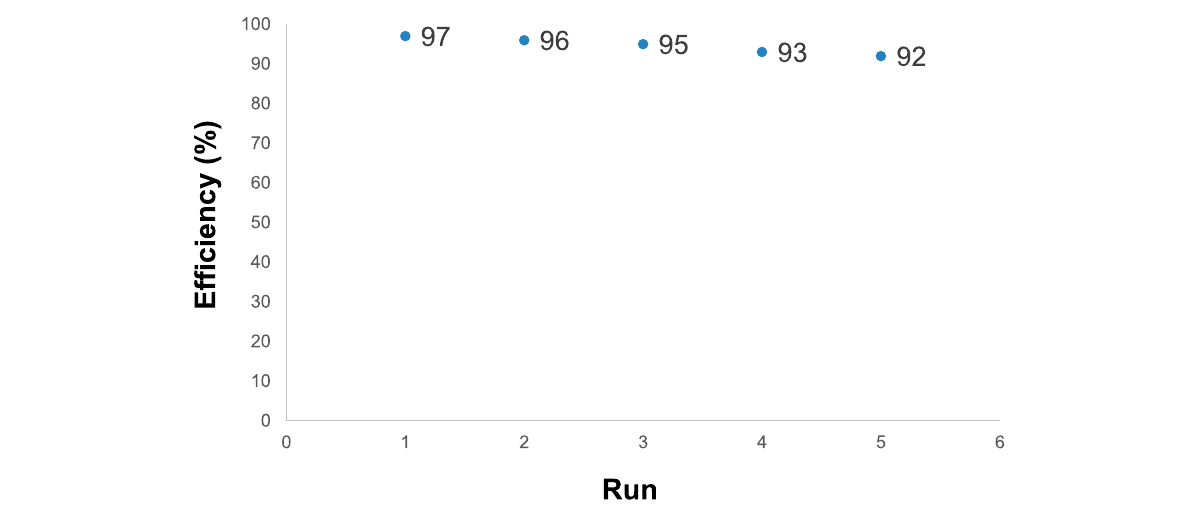
FIGURE 9 Fe 3 O 4 /Zn-metal organic framework magnetic nanostructures reusability in the synthesis of compound